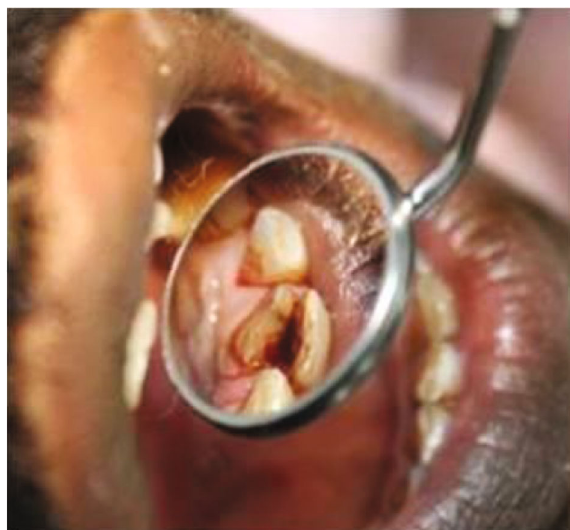
Figure 1: Preop photograph.